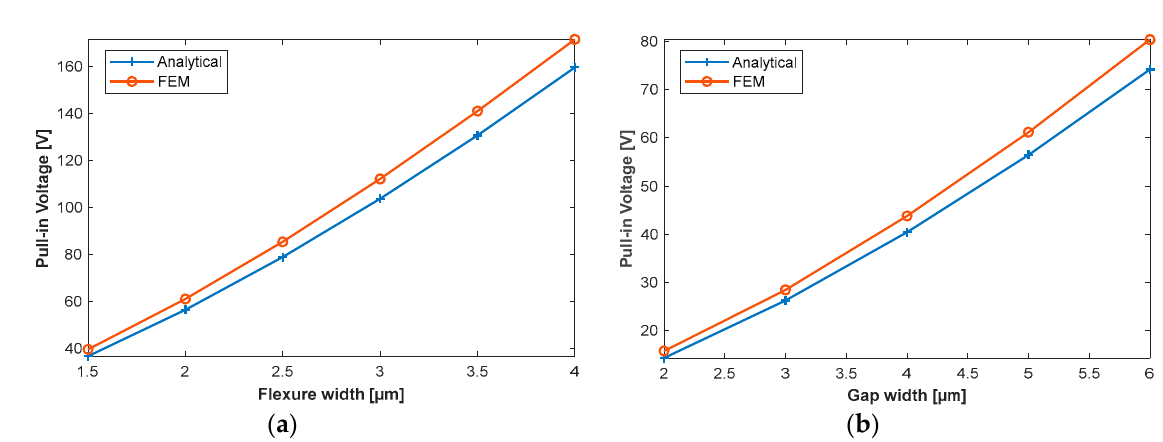
Figure 7. The results of static parametric analyses of the pull-in voltage, where the latter is plotted as a function of the following: ( a ) the flexure width (by sweeping both w x and w y ); and ( b ) the nominal gap width d . In the plots, the FEM results are compared with the analytical solutions that are based on Equation (7) and the stiffness formulations of the serpentine flexures presented in Appendix